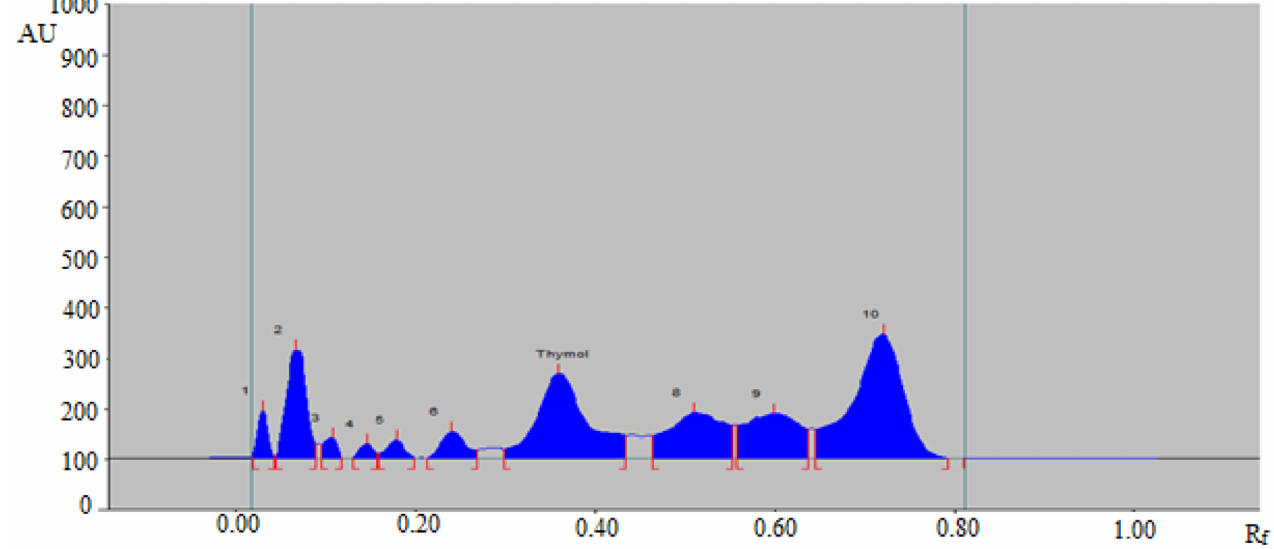
Figure 6. Representative HPTLC chromatograms of thymol in its commercial formulation. Table 5. Determination of thymol in commercial formulation, essential oil, and methanolic extracts extracted by traditional and ultrasound methods using a greener normal-phase HPTLC approach (mean ± SD; n = 3).